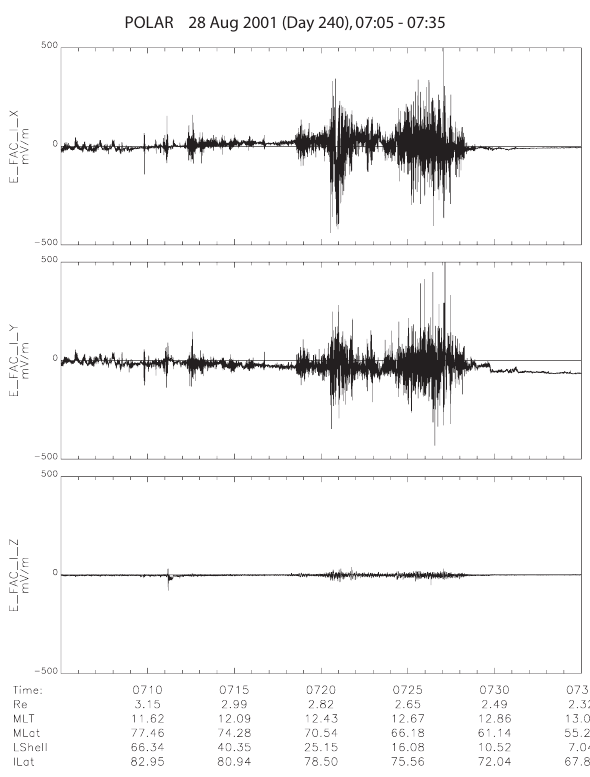
Figure 5a Fig. 5a. The presence of a field-aligned current (FAC) is indicated by this electric field data provided by the Polar EFI. In this figure the 3 panels display the x, y, and z components of E with z parallel to B.